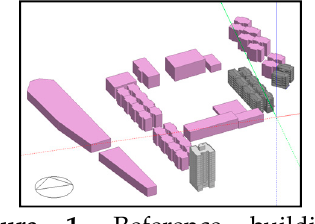
Figure 1. Reference buildings considering the three different